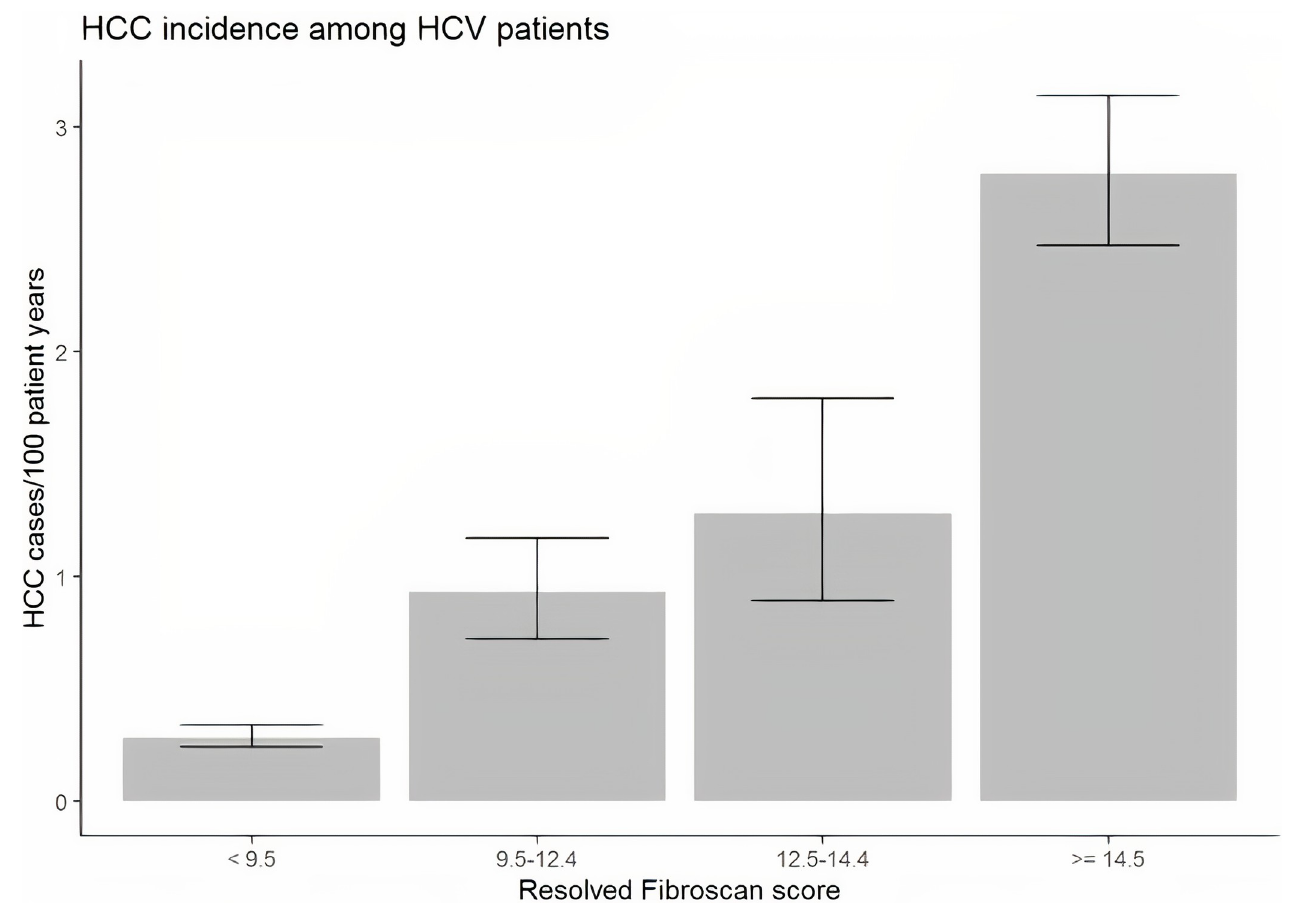
Fig 1. Incidence of HCC in veteran population with HCV stratified by TE score.